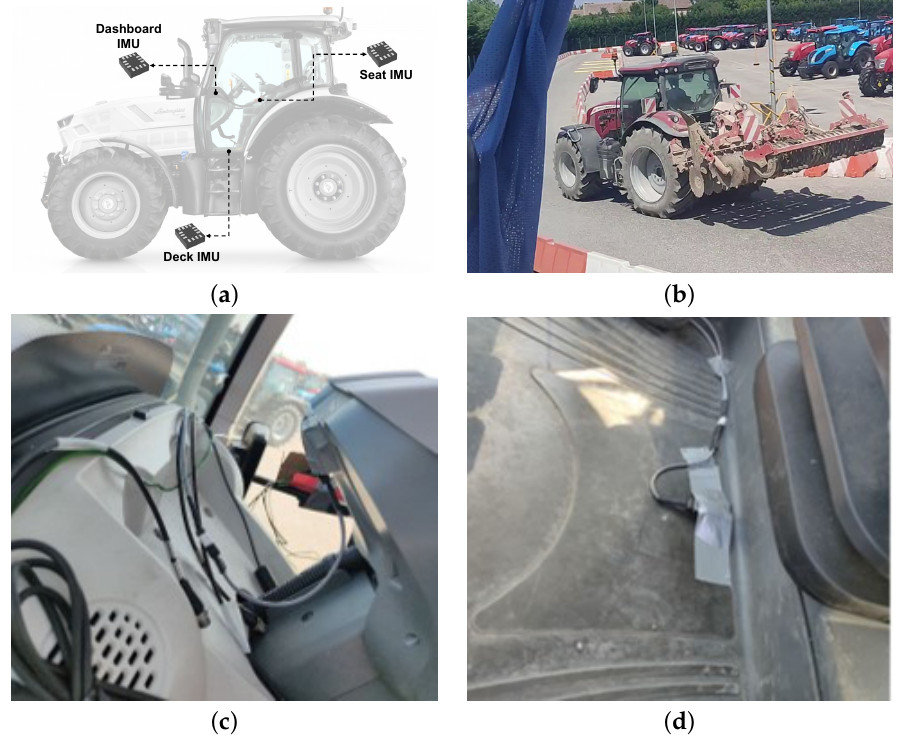
Figure 1. The tractor employed in this work, with a detail of the sensor mounting points. ( a ) Tractor; ( b ) trailer; ( c ) dashboard sensor; ( d ) deck